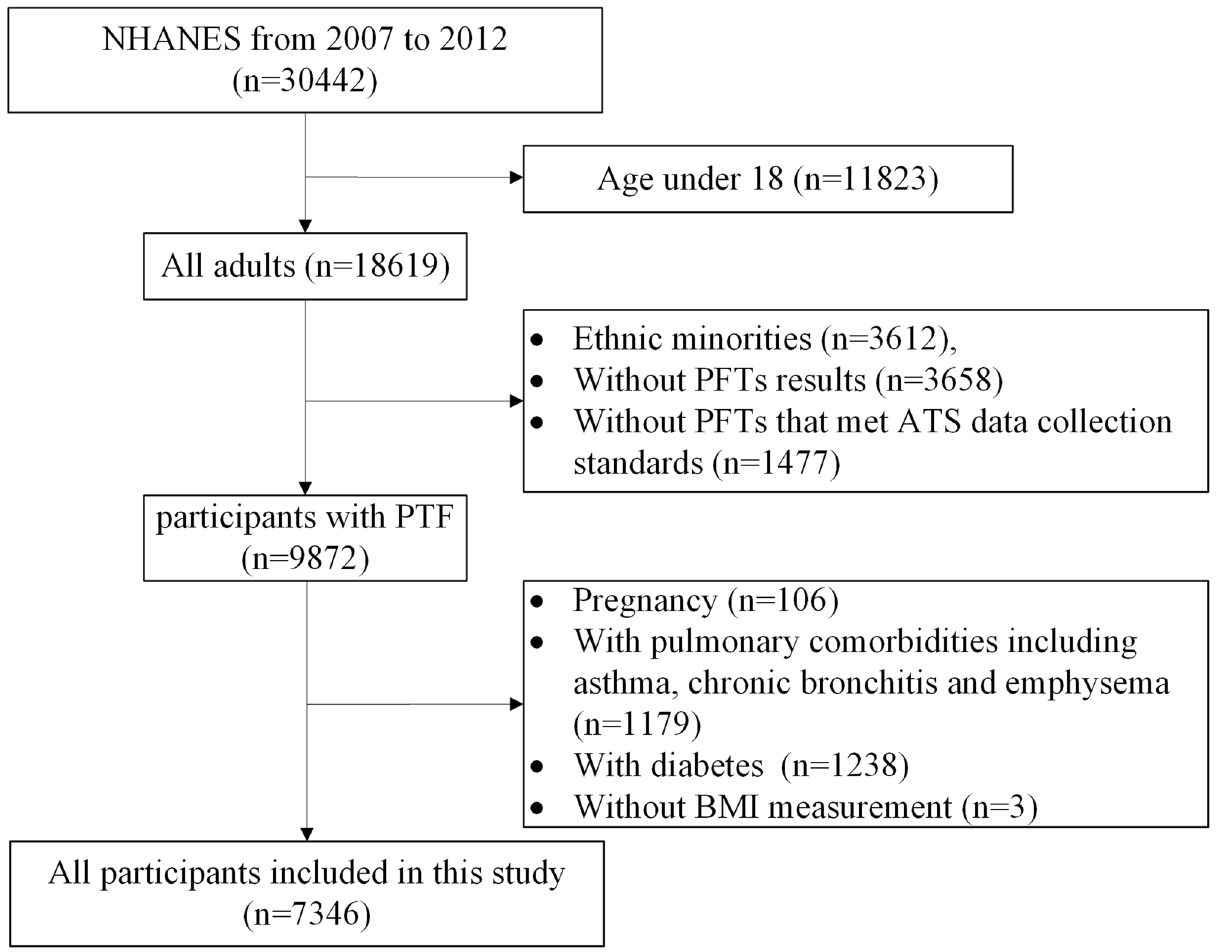
Figure 1. Flow gram of included participants. PFTs pulmonary function tests, ATS American Thoracic